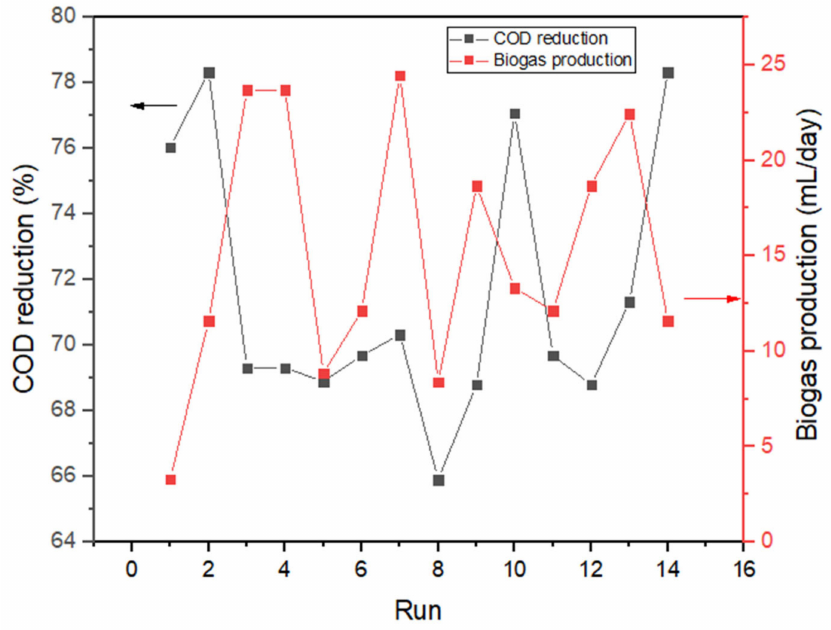
Figure 2. COD removal (%) response per CCD experimental